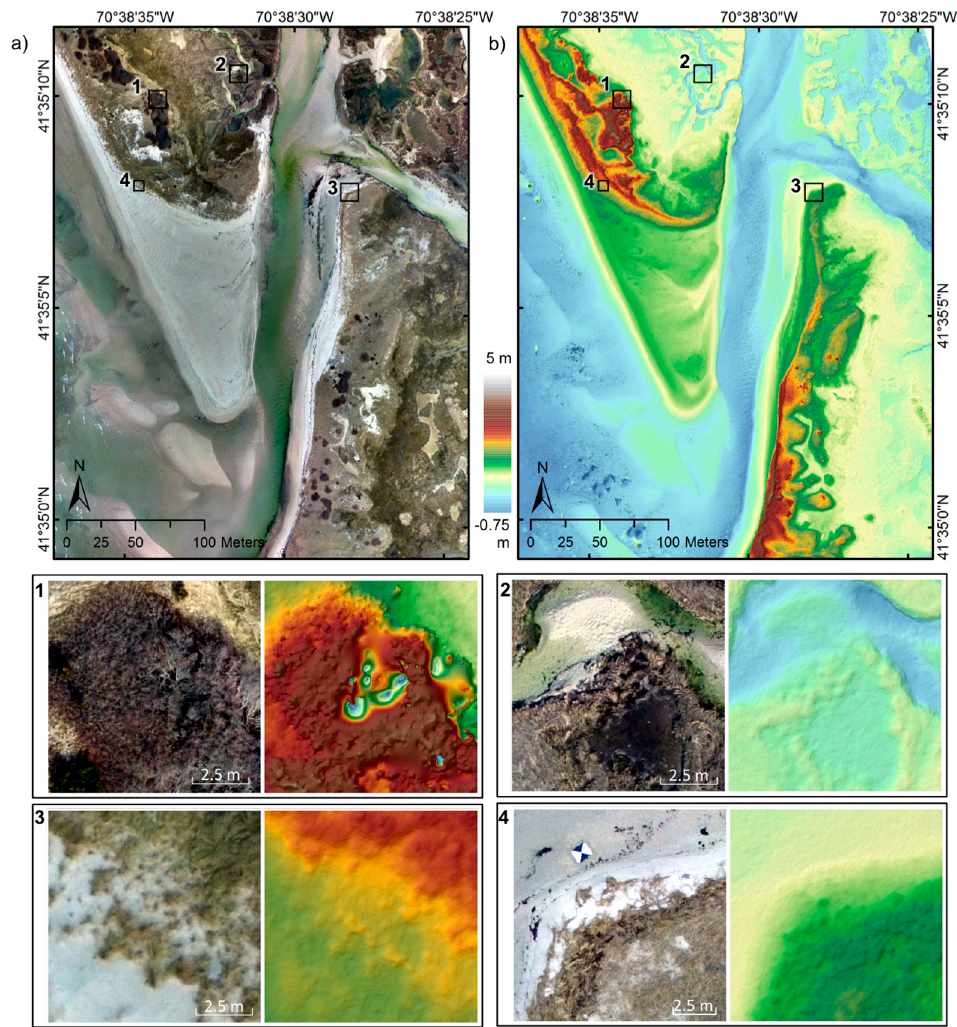
Figure 3. Raster surfaces produced from low-altitude aerial images using Structure-from-Motion (SfM): ( a ) orthomosaic image and ( b ) digital elevation model (DEM) displayed with hillshading. Inset maps demonstrate the degree to which landscape features are resolved in these products.